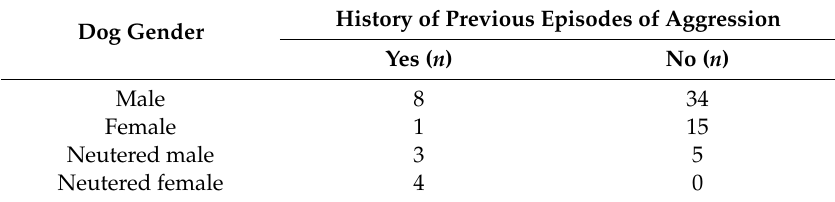
Table 11. Comparison of the history of previous episodes of aggression towards other dogs in di ff erent dog genders.